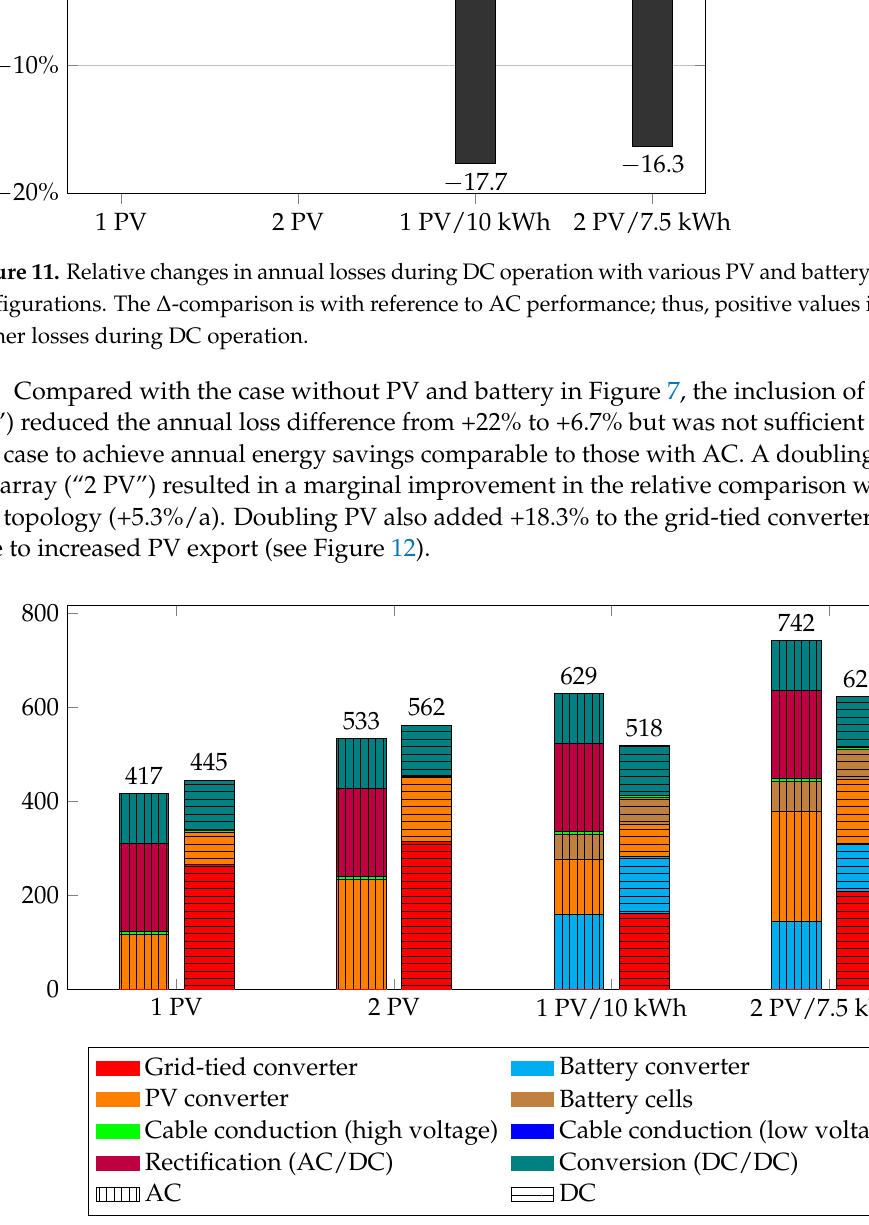
Figure 12. Loss split in AC and DC operations and the modelled PV and battery system configurations. Low-voltage cable conduction is zero for all topologies but is included in the legend for consistency with the other